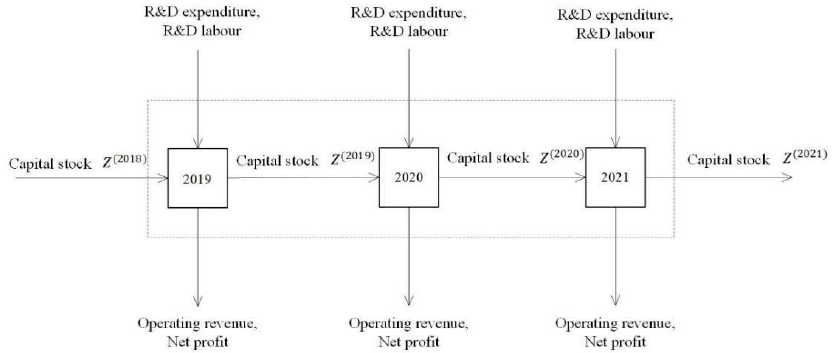
Figure 2. Dynamic system of inputs, outputs, and carry-over of DMUs.